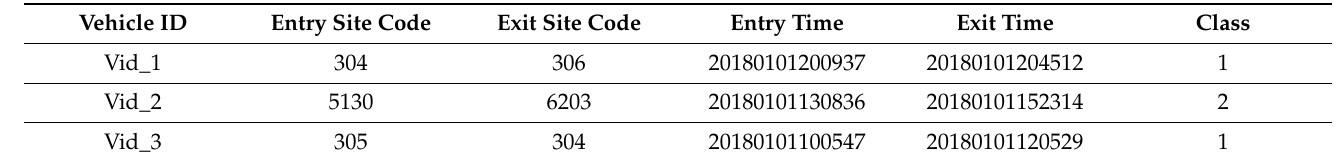
Table 1. Sample toll records.